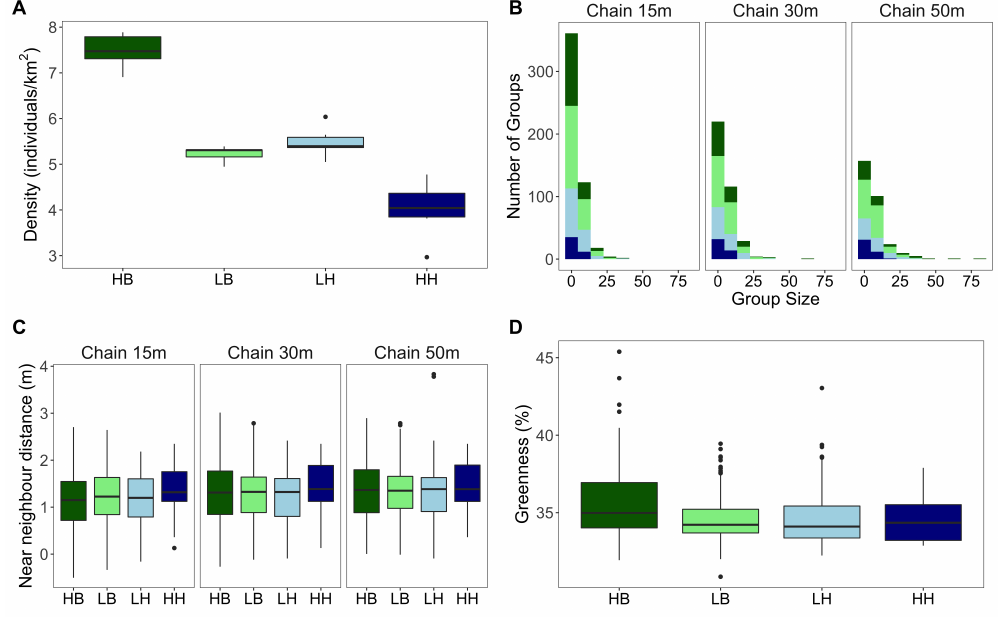
Figure 3. ( A ) Logged grazing density of eastern grey kangaroos in cleared habitat across different types of human disturbance. ( B ) Logged group size as a function of disturbance and different chain-rule (15 m, 30 m, and 50 m). ( C ) Logged nearest neighbour distance per group across disturbance types of human disturbance and at each chain-rule; 15 m, 30 m, and 50 m. ( D ) Resource greenness across disturbance types, error bars indicated standard error. Groups were determined using the 15 m chain-rule. For all plots human disturbance was expressed as an abbreviation; HB: High Benign (dark green), LB: Low Benign (light green), LH: Low Harm (light blue), HH: High Harm (dark